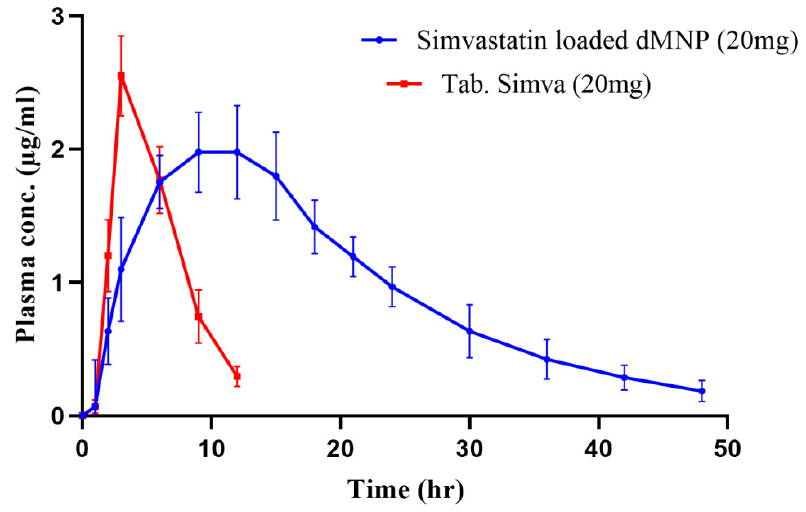
Figure 13. Plasma concentration vs. time graph. Table 6. Pharmacokinetic parameters of Simvastatin after administration of dMNP and oral solution. F26 Table Simva Solution Parameters (Mean ± S.D) (Mean ±